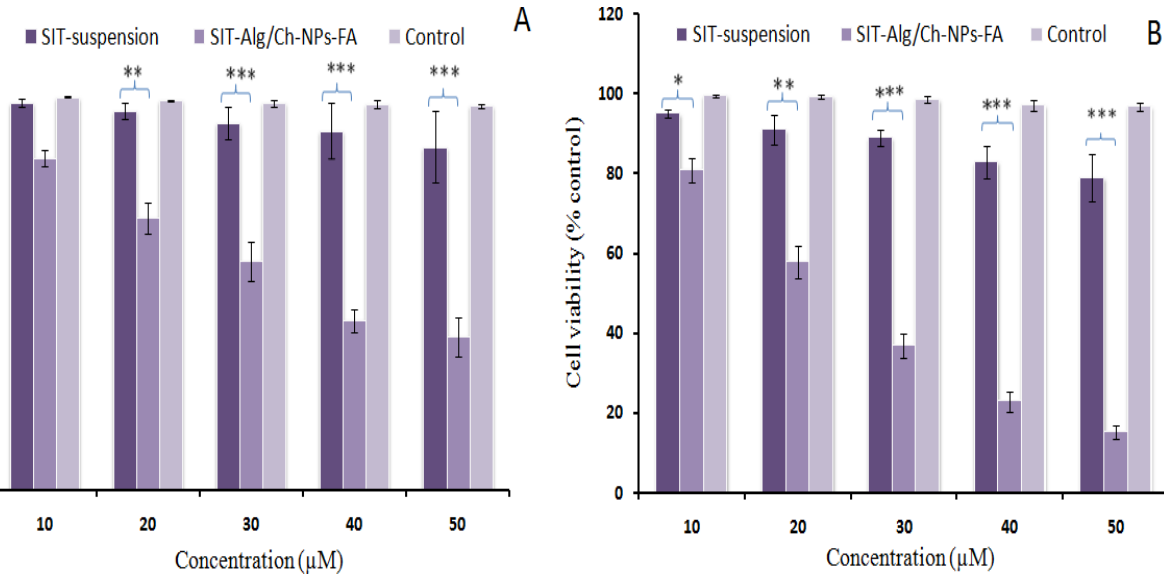
Figure 8. Percentage cell-viability assessment of β -SIT-Alg/Ch-NPs-FA and SIT-suspension at varying concentrations of (10, 20, 30, 40, and 50 µ M) after incubation time of 24 h ( A ) and 48 h ( B ) in breast cancer cell line. Data expressed as mean ± SD ( n = 3). Significant levels were (* p < 0.05), (** p < 0.01), (*** p < 0.001) when formulation SIT-Alg/Ch-NPs-FA compared with SIT suspension.